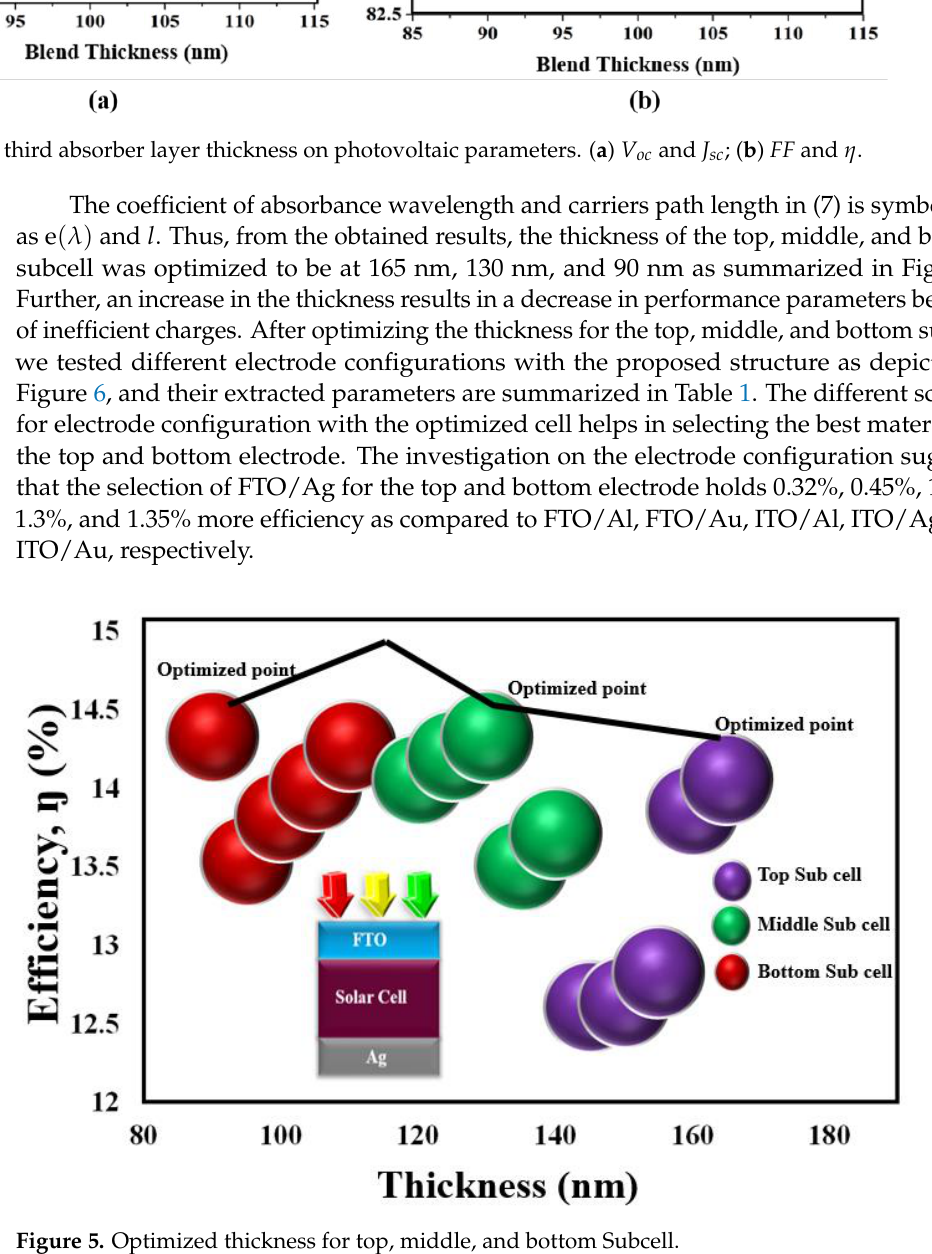
Figure 5. Optimized thickness for top, middle, and bottom Subcell.